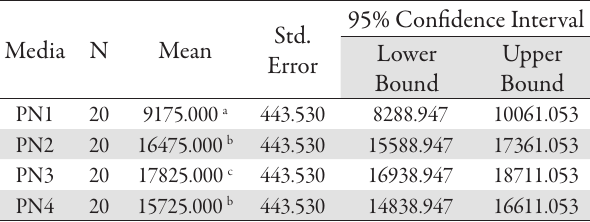
Tab. 3. Comparison of Media means using DMRT